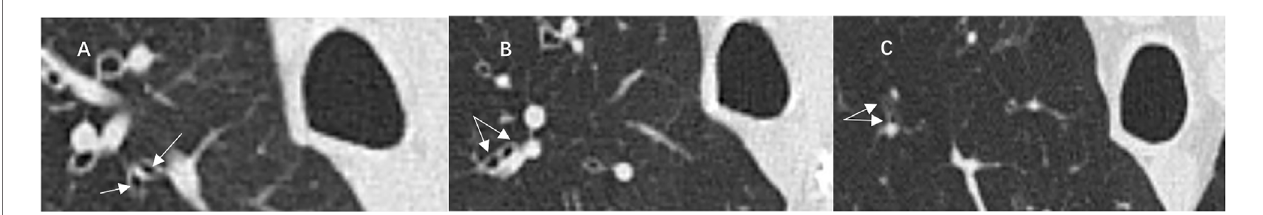
FIGURE 2 | Illustrative case of computed tomography (CT) images showed distal airway branches of the right upper lobe apical bronchus (RB1). Airway branches (arrows) of the sixth (A) , seventh (B), and eighth (C) generations of RB1.